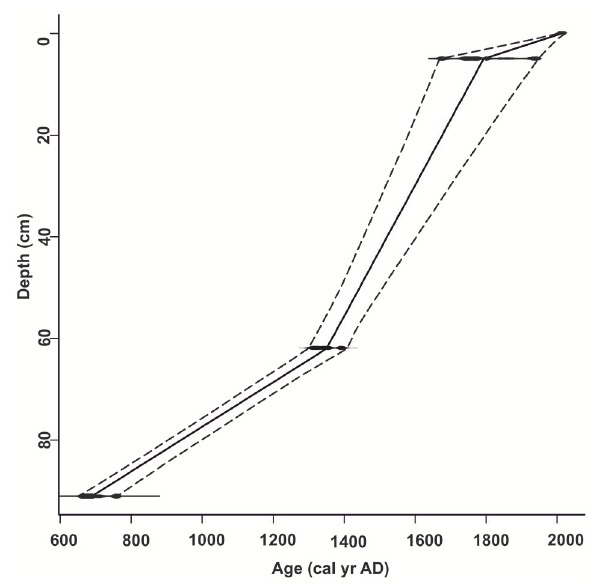
FIGURE 2 | Age-depth model based on radiocarbon dates using linear interpolation. The age of organic core samples is measured as calibrated years AD (cal yr